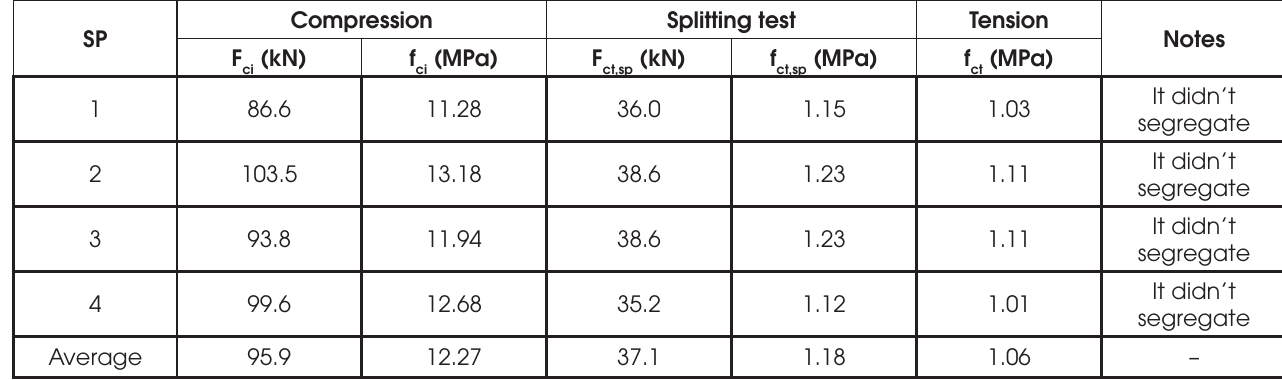
Description of 3 rd batch from SLCEB Compression Splitting test SP